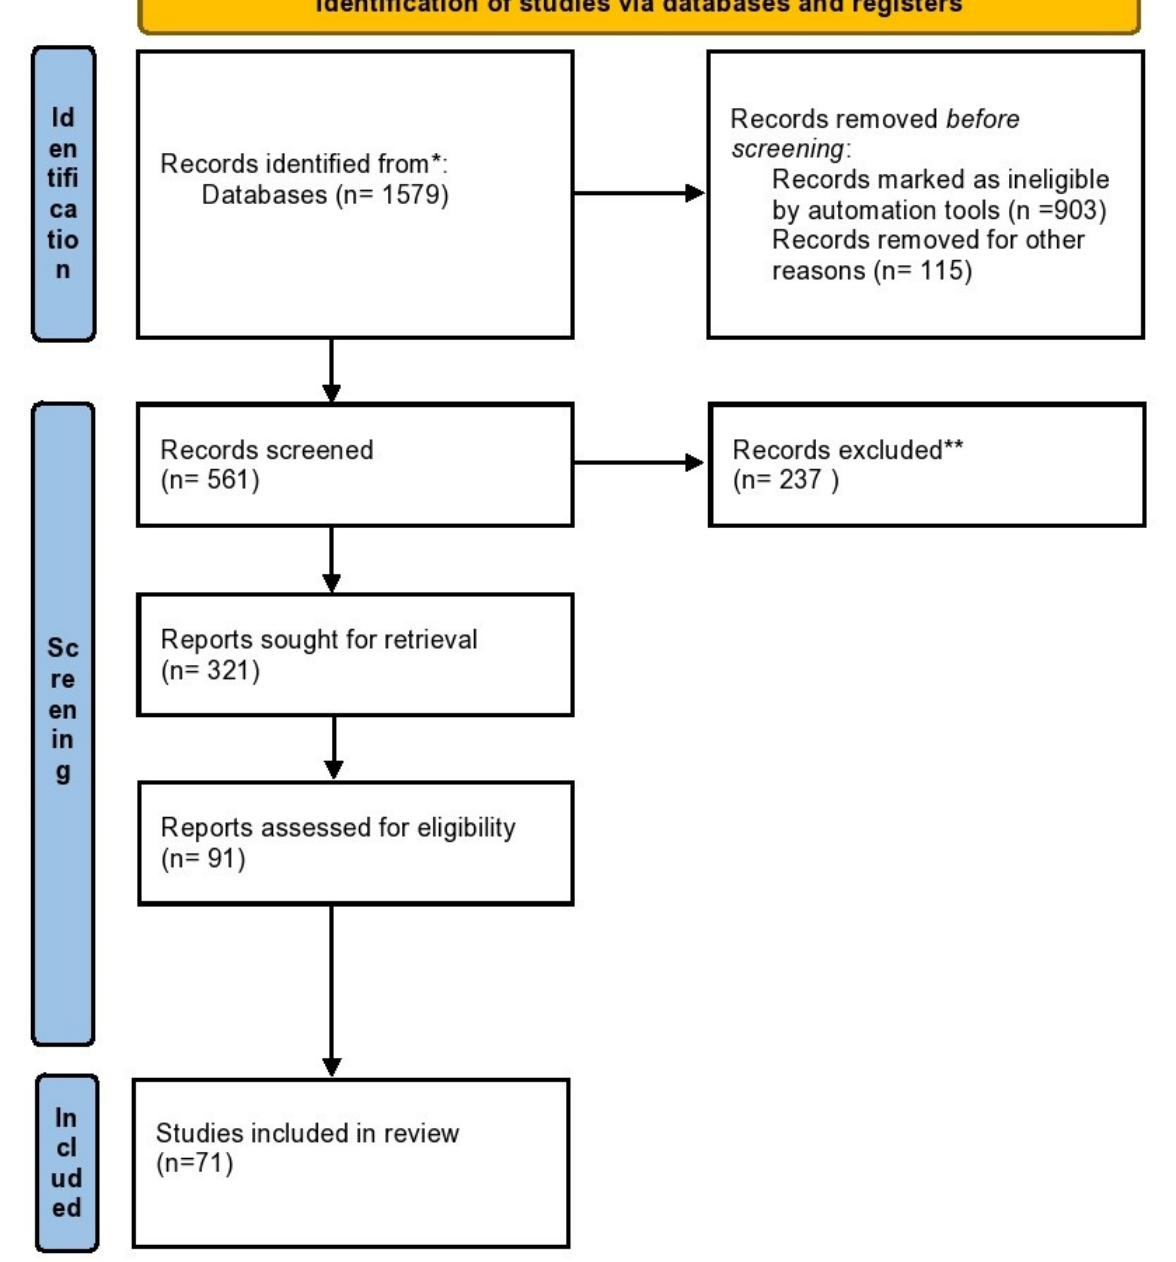
Figure 3. The flow chart illustrating the study methodology. Legend: * Scopus, Medline and Pubmed bases; **references that are not relevant to the topic.